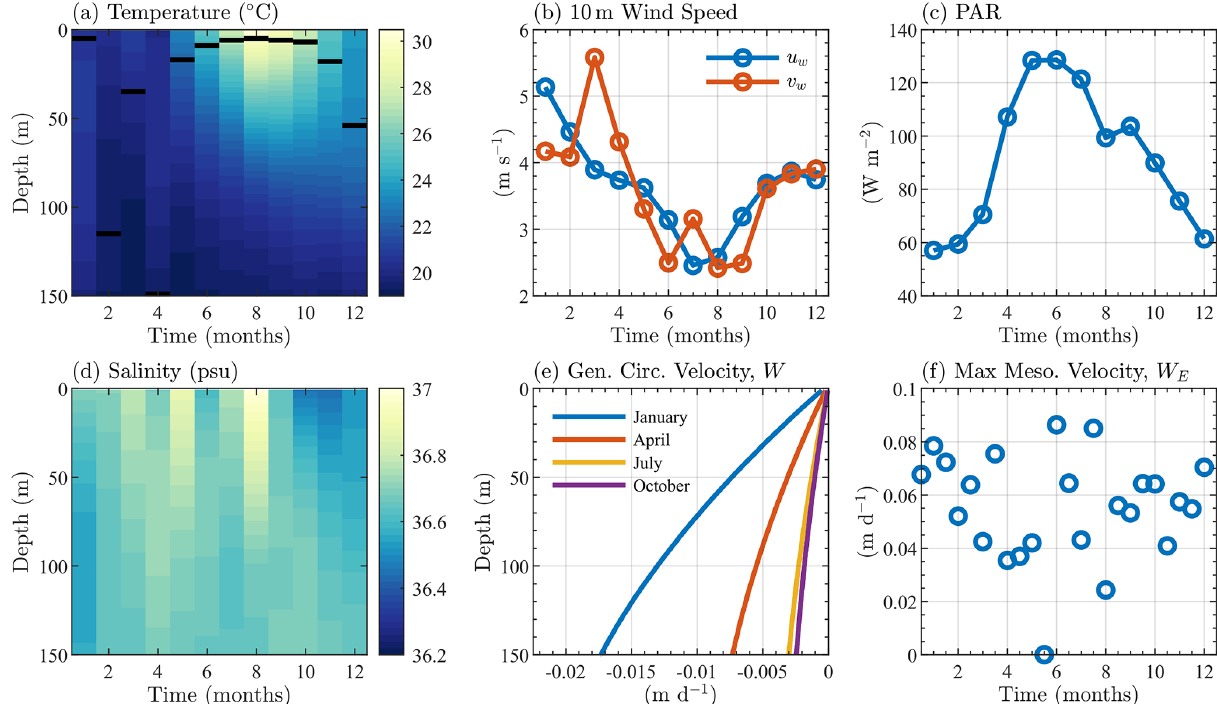
Figure 2. Sargasso Sea physical variables, showing climatological monthly averaged (a) temperature, (b) 10m surface wind speed, (c) surface PAR, and (d) salinity. Panel (e) shows the mean seasonal general circulation velocity, W , and panel (f) shows the bimonthly maximum value of the mesoscale eddy velocity W E . Monthly averaged mixed layer depths (defined as the depth at which the density is 0.2kgm − 3 greater than the surface density) are shown as black lines in panel (a)